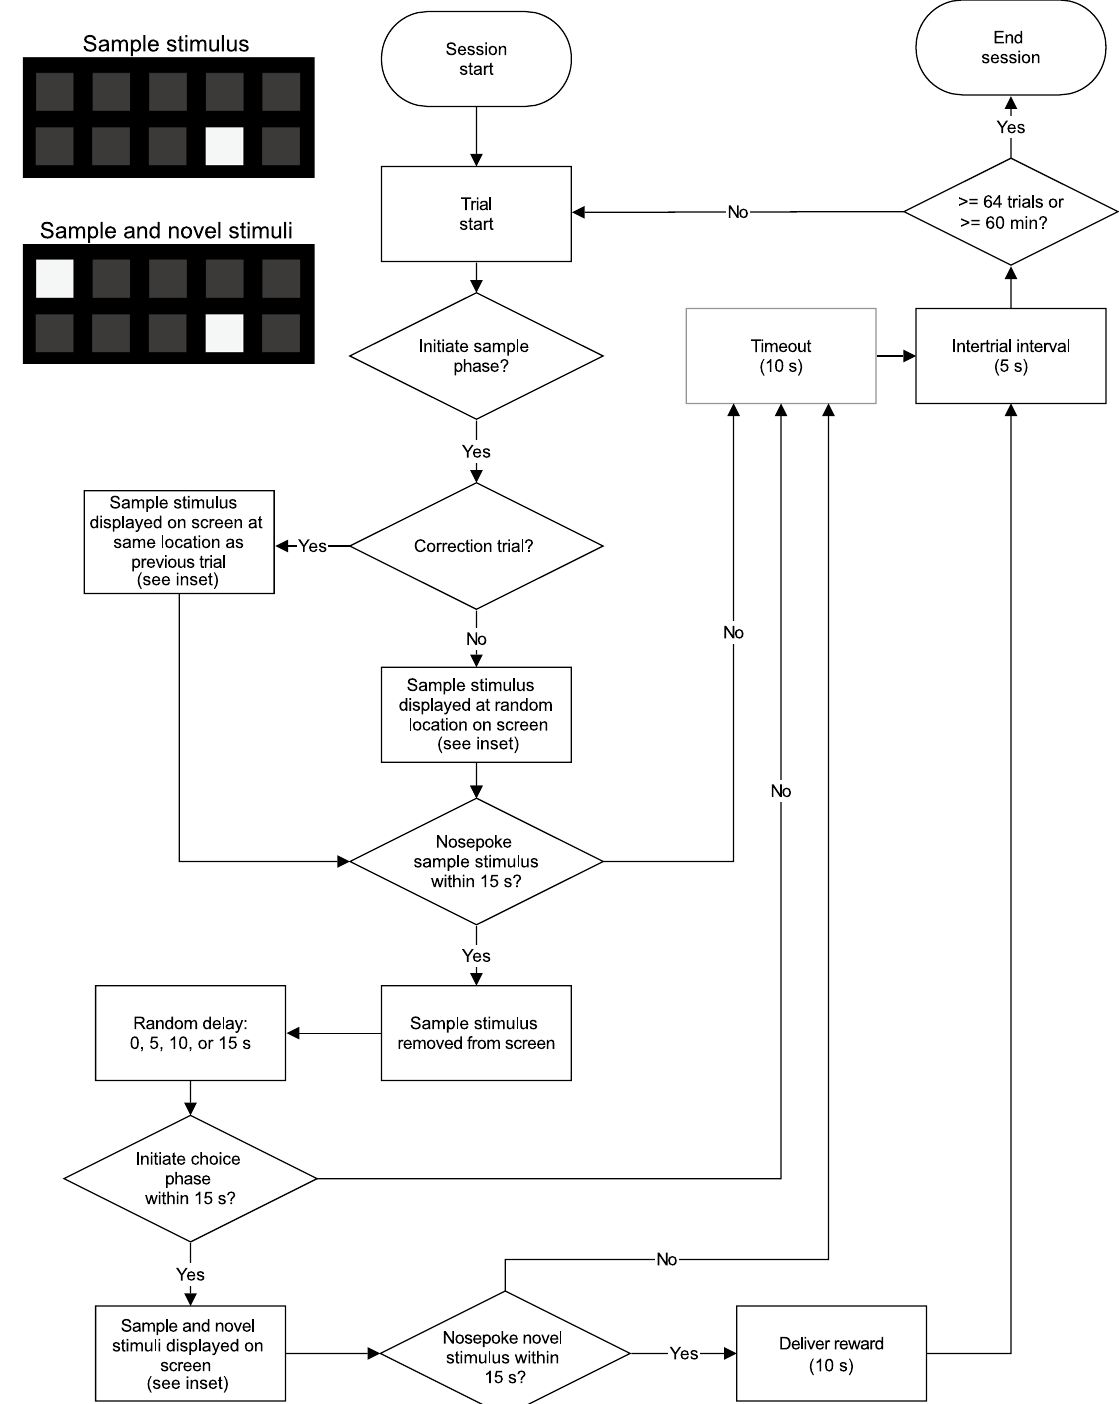
Figure 1. The TUNL assay for quantification of working memory and pattern separation in C57BL/6J and DBA/2J mice. The flowchart illustrates the different phases of the TUNL assay. The inset illustrates the stimuli that were displayed on the touchscreen during the sample phase and the choice phase. Dark gray stimuli shown in the inset illustrate the matrix of possible locations for the sample and novel stimuli; in the TUNL experiment, only the white sample stimulus and white novel stimulus were shown on the touchscreen. During correction trials, both the sample stimulus and novel stimulus were displayed at the same locations as they were displayed in the preceding trial. During non-correction trials, the sample stimulus and novel stimulus were displayed at random